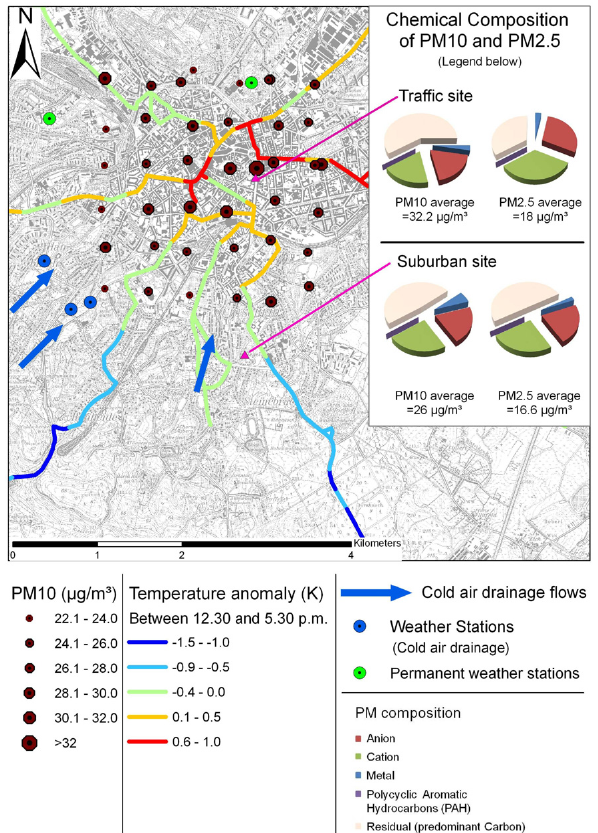
Figure 6. GIS-based investigations covering spatial PM and tem- perature distribution, cold air drainage flows and chemical compo- sition of PM 10 and PM 2 . 5 in the city of